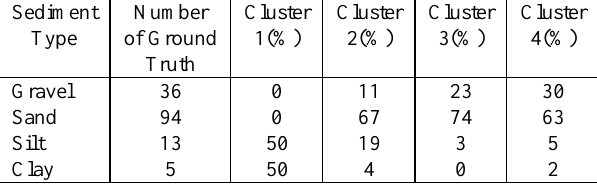
Table 4: Cross tabulation between the GLCM Contrast cluster